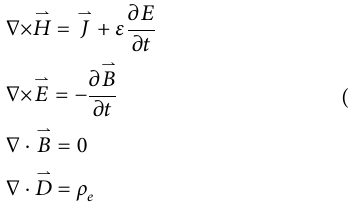
FIGURE 5 Schematic of a staggered slot arrangement.